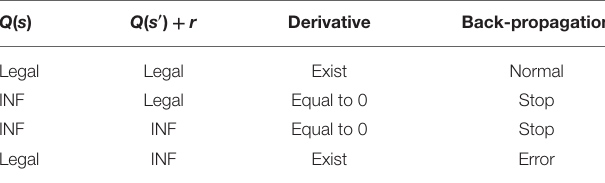
TABLE 1 | Back-propagation cases in RL tasks. Q ( s